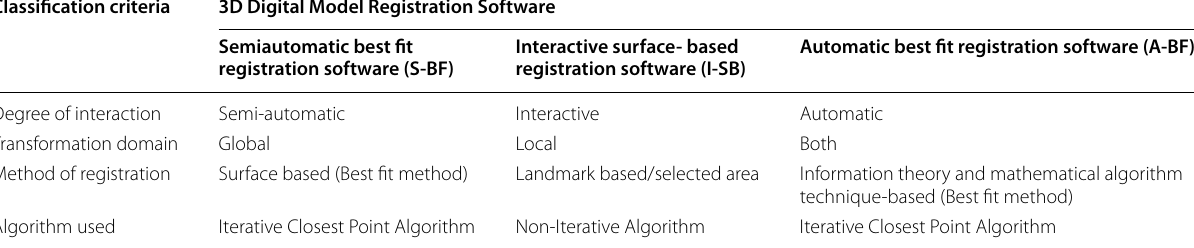
Table 1 Software packages employed and their mode of operation [16] Classification